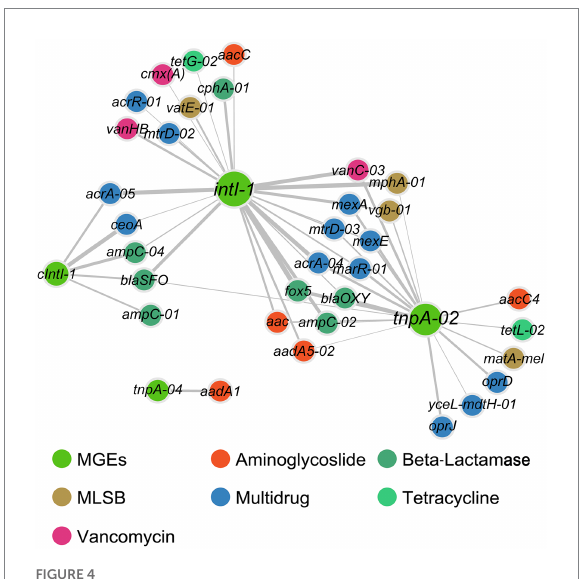
FIGURE 4 Bipartite network analysis showing associations of MGEs with ARGs. The edges with correlation coefficient > 0.8 and p < 0.01 by at least two methods (among Spearman correlation, Pearson correlation, Kullback–Leibler dissimilarity, and Bray–Curtis dissimilarity) were considered statistically robust and visualized. Line thickness is proportional to correlation